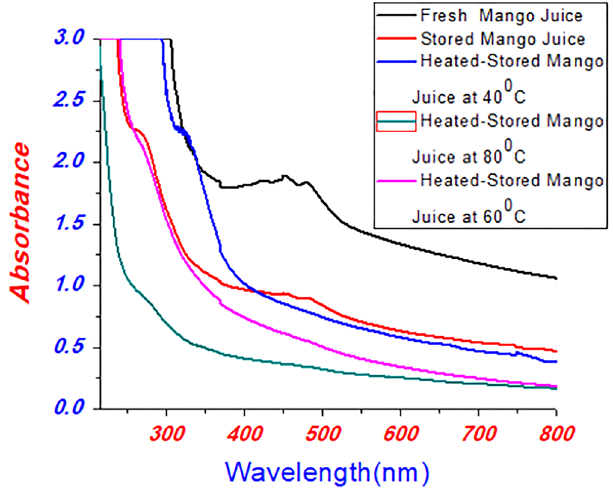
Figure 2. UV/Vis absorption spectra of mango juices.